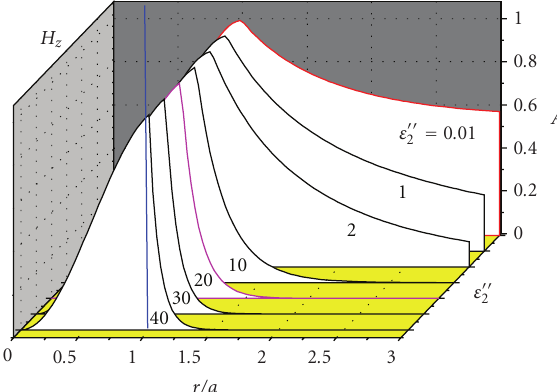
Figure 4: The normalized distribution of the H z field component for the rod in high loss medium. The relative distance r/a in radial direction is across, the solid vertical line is the rod border, ε (cid:2) 2 = 20. The numbers denote the values of imaginary CP part ε (cid:2)(cid:2) 2 = 0 . 01;1;2;10;20;30;40. values of complex permittivity parts ( ε (cid:2) the ratio of wave impedance ζ =